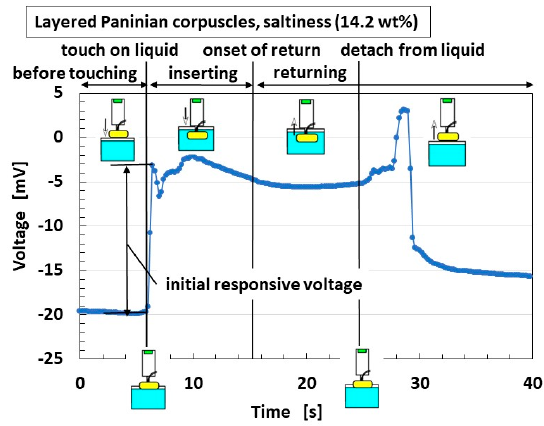
Figure 13. Typical result of built-in voltage responsive to flavored liquid.